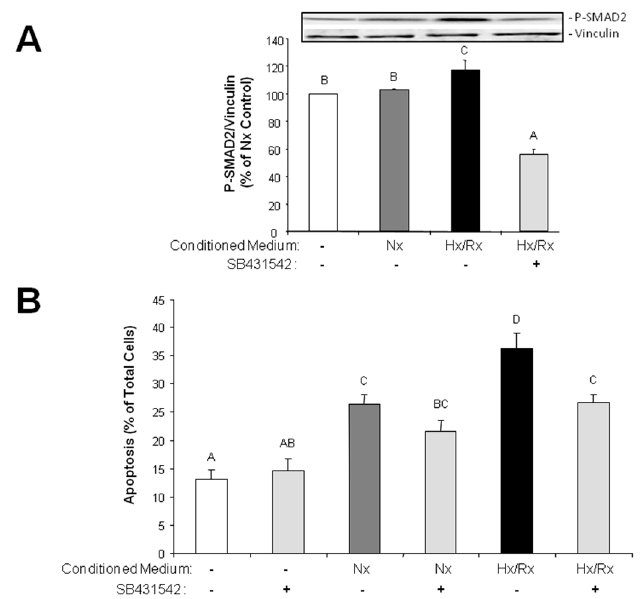
Figure 4. Apoptosis induction in ventricular cardiomyocytes by conditioned medium from hypoxic/reoxygenated endothelial cells via ALK5 receptor. Endothelial cells were exposed to one hour hypoxia or normoxia and two hours reoxygenation. Then conditioned medium of normoxic (Nx) or hypoxia/reoxygenated (Hx/Rx) cells were added to ventricular cardiomyocytes in presence or absence of the ALK5 inhibitor SB431542 (1 µM). Control cardiomyocytes were cultured in normal normoxic medium for cardiomyocytes. ( A ) After two hours total protein was extracted and Western blots performed using phospho-SMAD2 or vinculin antibodies. Representative Western blots, and quantification of protein expression are depicted. For quantification phospho-SMAD2/vinculin ratios are expressed as percent increase relative to normoxic controls, and are means ± SE of n = 8 independent culture preparations. Uppercase letters indicate significant differences between groups with p ≤ 0.05; ( B ) After 24 h the rate of apoptotic cardiomyocytes was determined by staining nuclei with Hoechst 33258 for detection of chromatin condensation. Number of apoptotic cells is calculated as percent of total cells and are presented as means ± SE of n = 4 independent culture preparations. Uppercase letters indicate significant differences between groups with p ≤ 0.05.